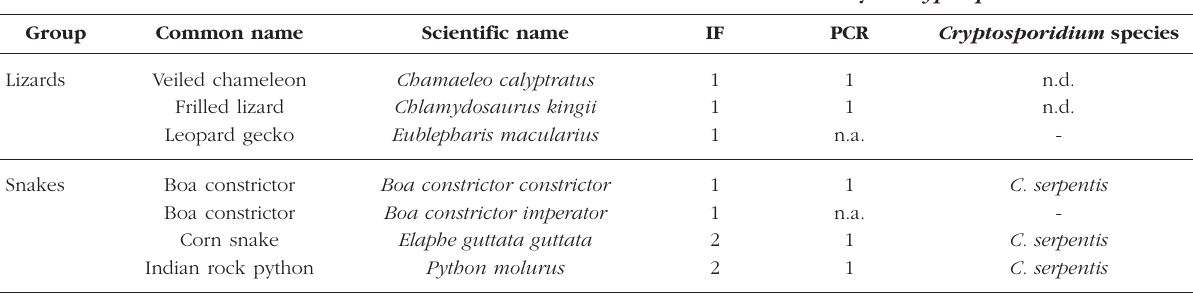
Table I. – List of the reptile species that tested positive by IFA for the presence of Cryptosporidium